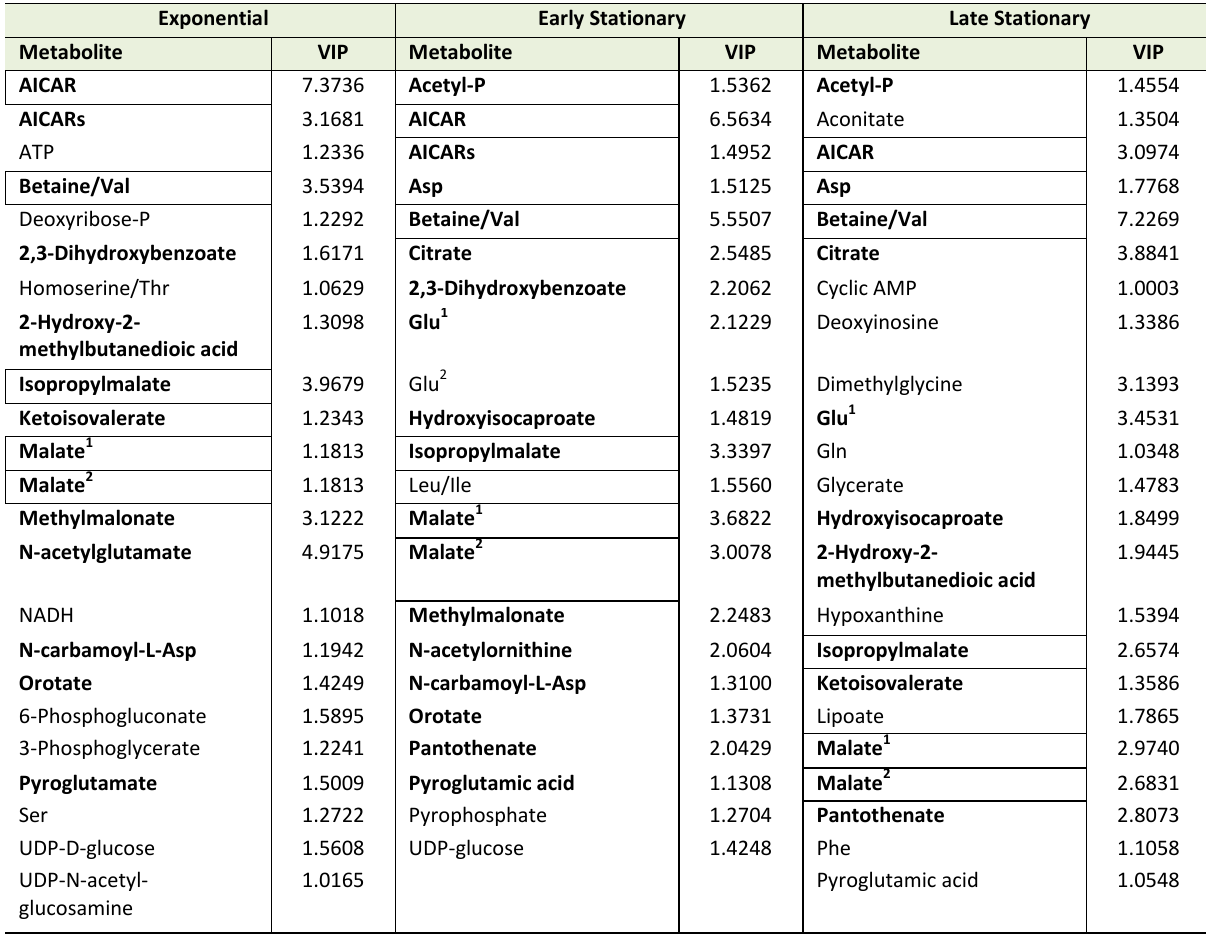
TABLE 1. Important metabolites as determined by